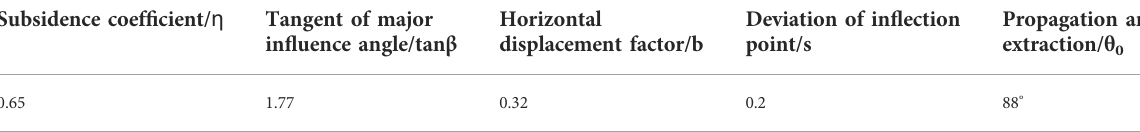
TABLE 1 Parameters of the rock strata and surface movement of the 42201 working face.